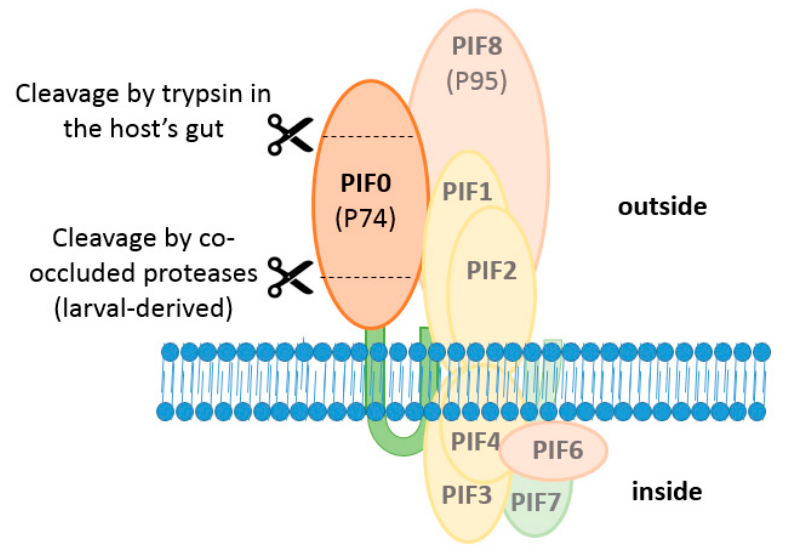
Figure 7. Two step cleavage model of PIF0. Firstly, PIF0 is cleaved by co-occluded host-derived proteases when larval-derived OBs dissolves in an alkaline environment. These 35 and 40 kDa fragments remain associated with the core complex. Secondly, a 20 kDa N-terminal fragment is cleaved off by trypsin in the host’s gut.